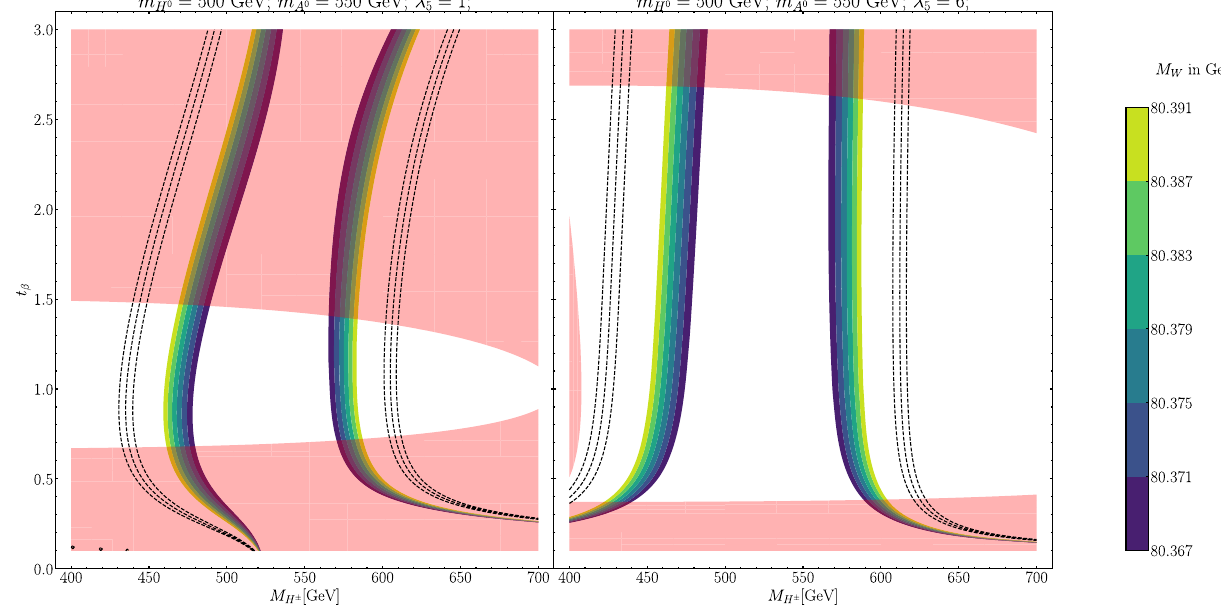
Fig. 3 Influence of m H ± and t β on the theoretical prediction of M W . The bands indicate the parameter configurations for which the calcu- lated M W iswithinthe1 σ uncertaintiesofthemeasuredvalues,thePDG